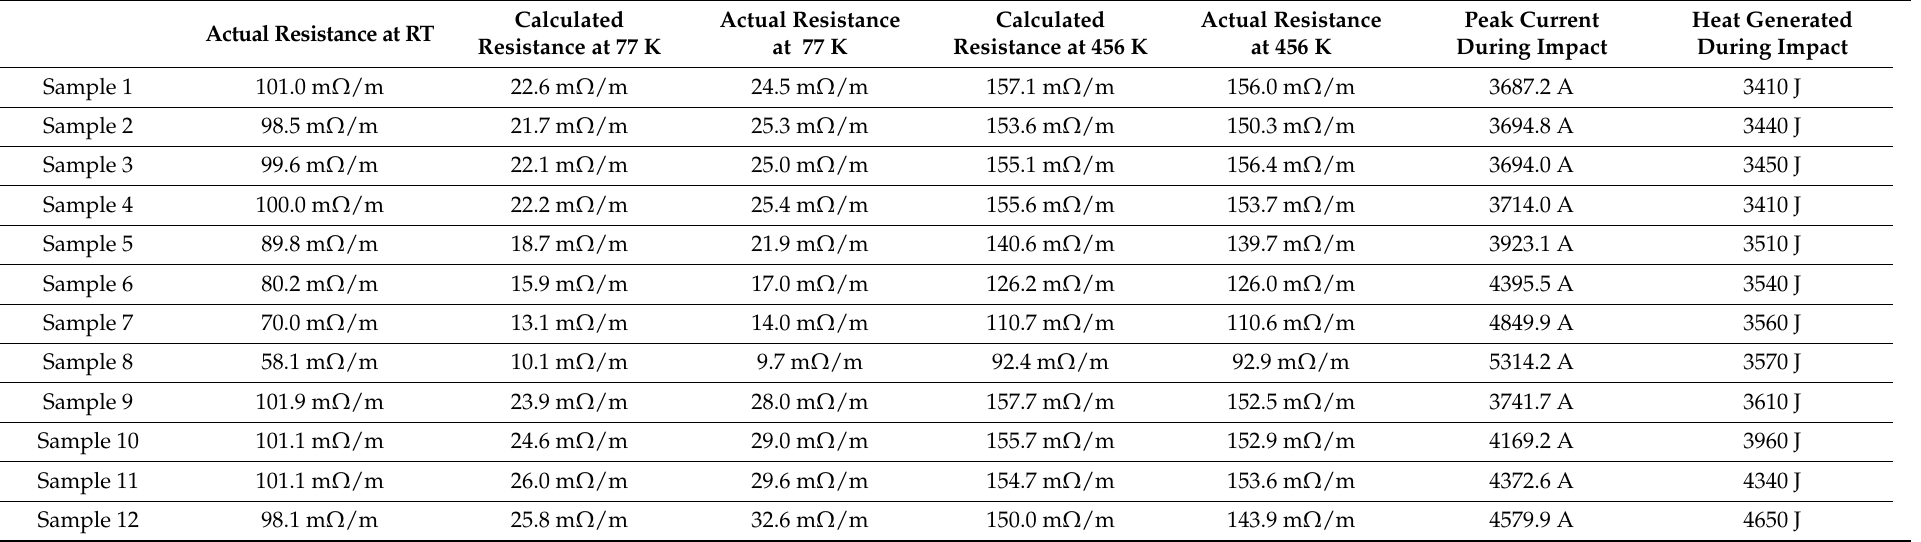
Table 3. Copper-plated and laminated HTS tape